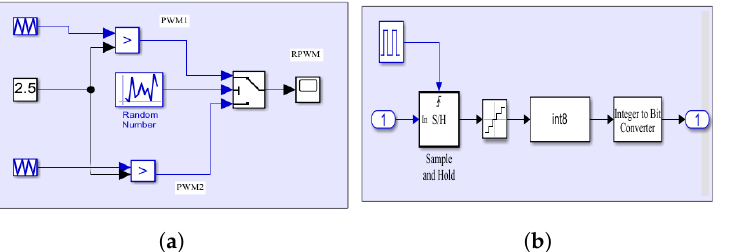
Figure 5. SIMULINK implementation of the ( a ) RPWM control system; and ( b ) the analog-to- digital